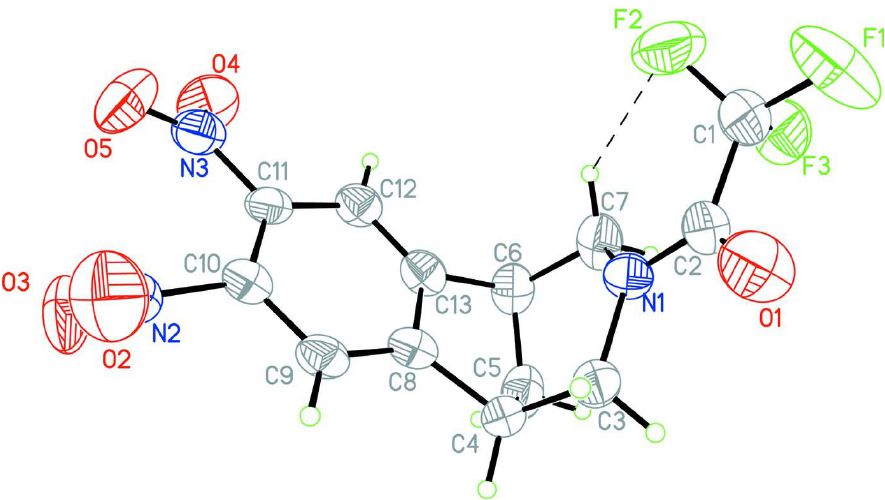
Figure 1 The molecular structure of the title molecule, with the atom-numbering scheme. Displacement ellipsoids are drawn at the 30% probability level. Hydrogen bond is shown as dashed